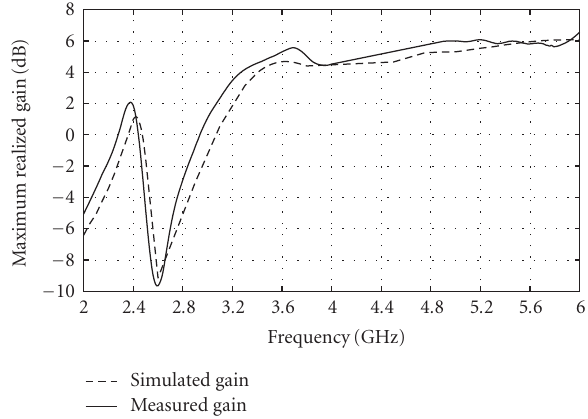
Figure 6: Simulated reflection coe ffi cient for di ff erent PCB dimen- sions.